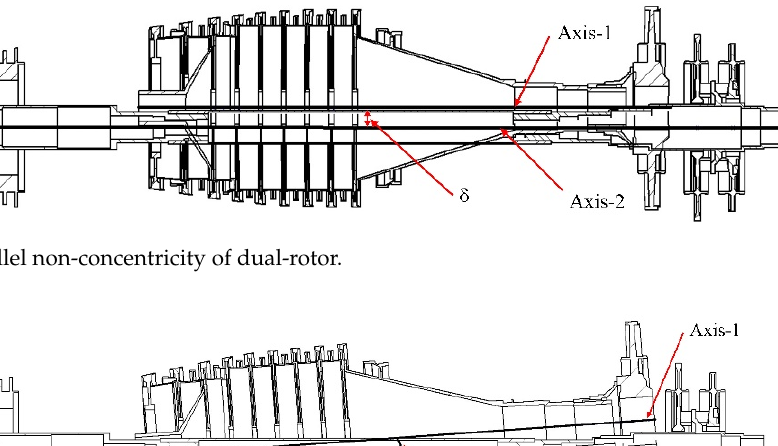
Figure 10. Parallel non-concentricity of dual-rotor.